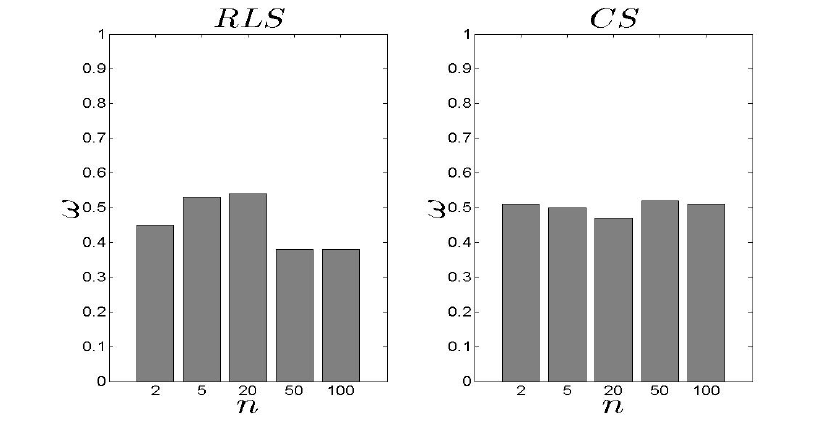
Figure 7. RLS and CS results for the ω metric ( |F| =